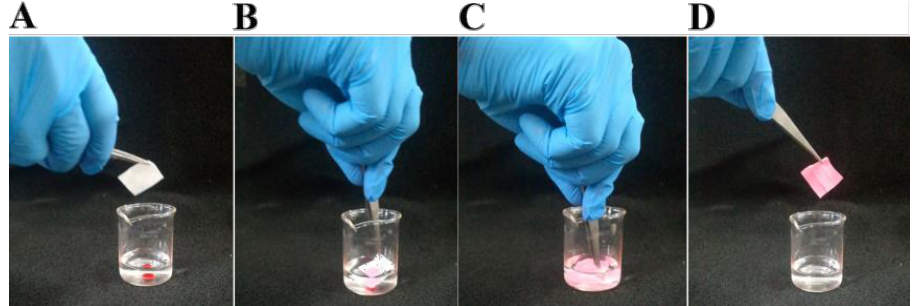
Figure 8 . The modified cotton fabric absorbed underwater dichloromethane (DCM) droplets ( A ) DCM drops in the bottom of the water ( B ) modified fabric dipped into the solution ( C ) absorbing the DCM from the water bottom ( D ) DCM absorbed by the modified cotton fabric. Figure 9. The separation of oil from oil–water mixture by the modified fabric ( A ) mixture of DCM red oil and blue water, ( B ) pour into the oil–water separation device, ( C ) amount of water, and ( D ) amount of purifying DCM.